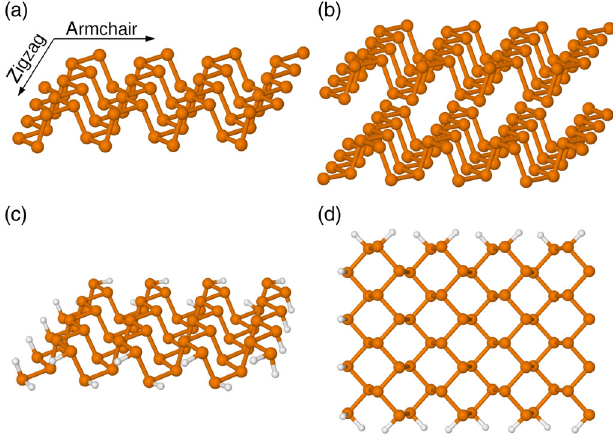
FIG. 1. Atomic structure of (a) single-layer and (b) few-layer phosphorene. Characteristic armchair and zigzag directions are indicated in (a). Side and top views of a 4 × 4 cluster approx- imant, with saturated edge bonds, are presented in (c) and (d),